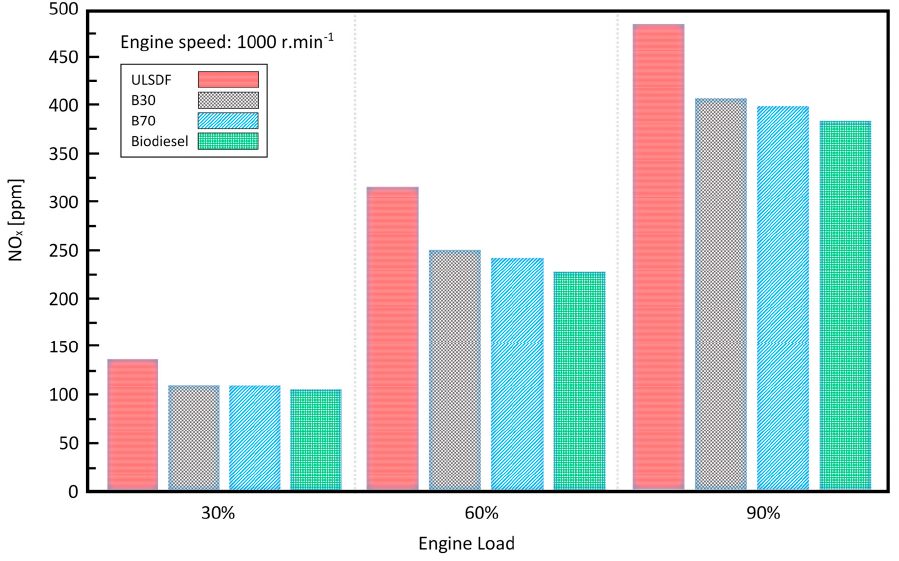
Figure 8. The dependence of testing fuels on the NO X emissions (1000 rpm).